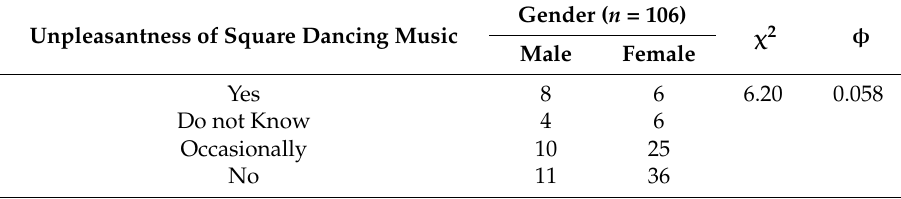
Table 8. Chi Squared Test comparing gender to enjoyment of watching square dance. Enjoyment of Watching Square Dancing Yes